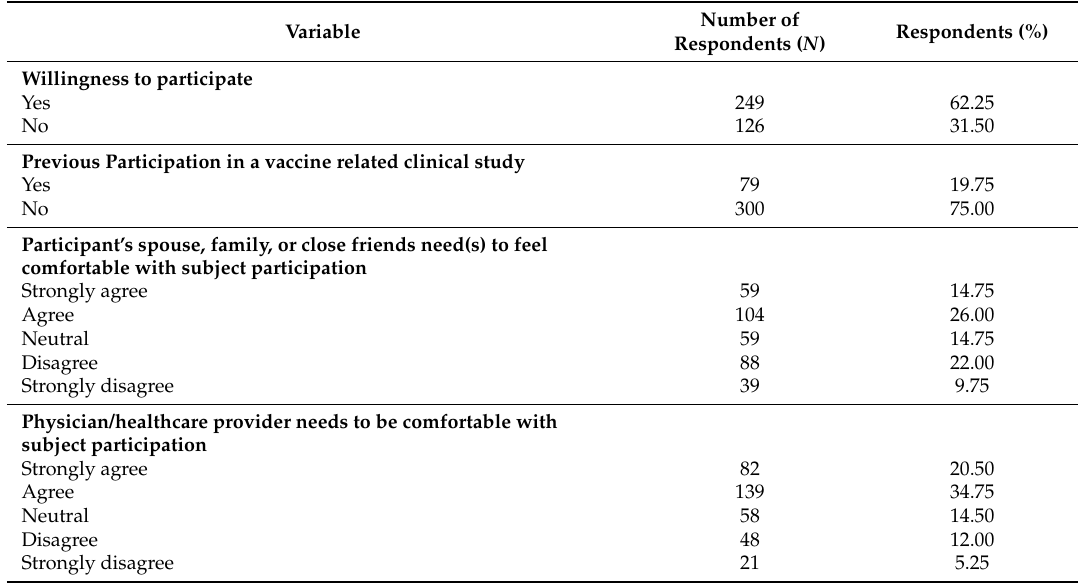
Table 2. Population characteristics and perceptions about clinical trials among 400